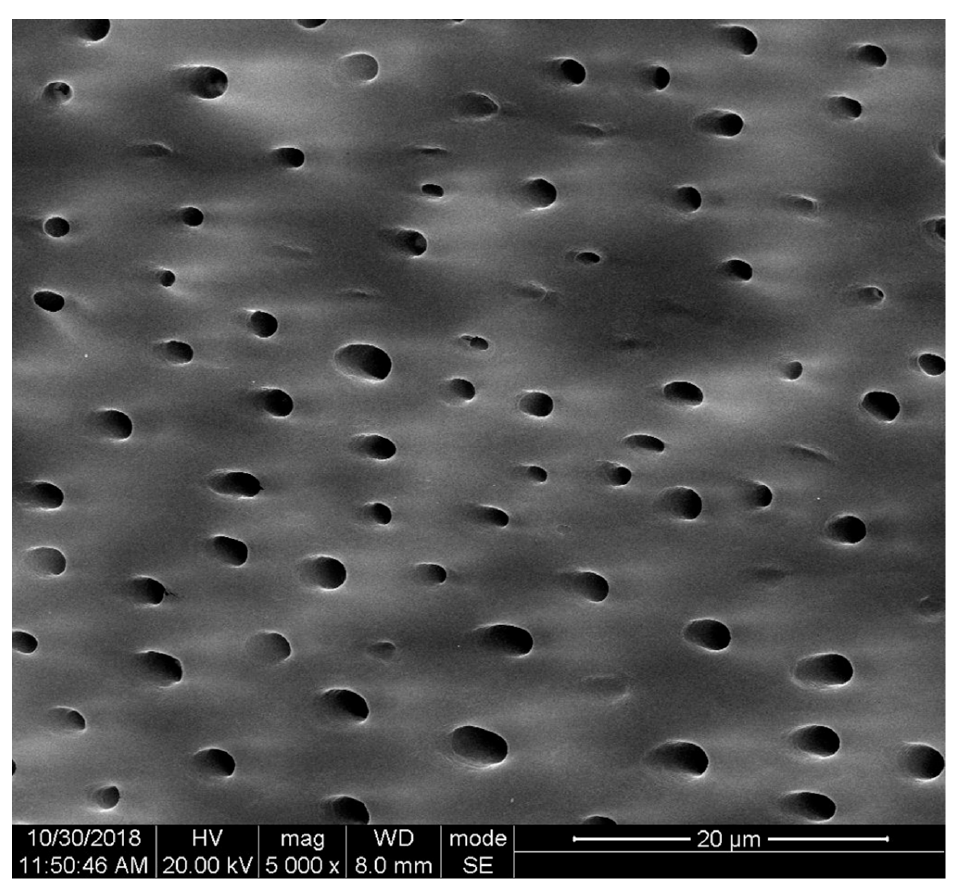
Figure 1. Treated dentin matrix image taken using SEM, where exposed dentinal tubules are shown.